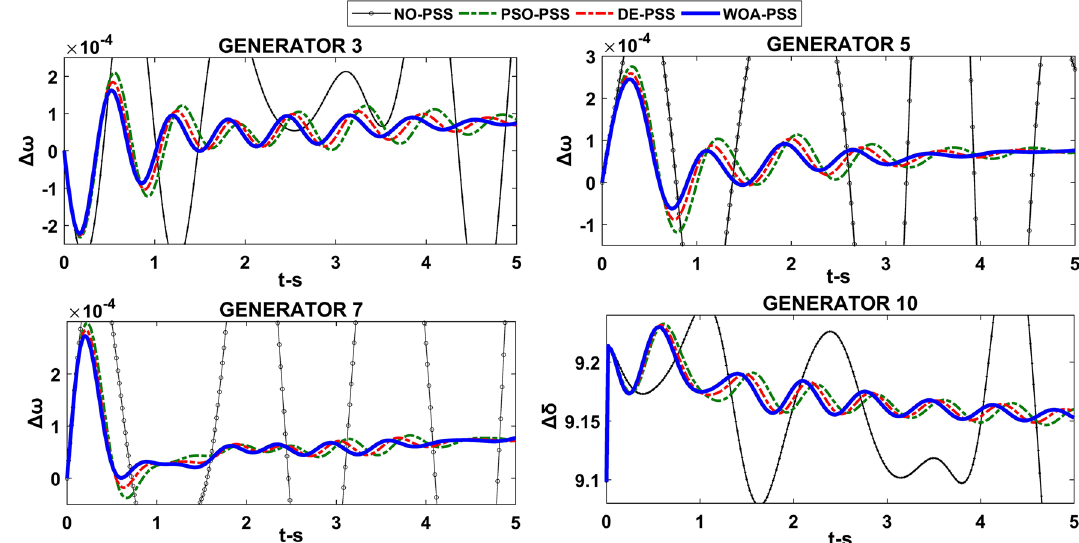
Fig. 11 Speed deviation plots under the disturbance of line outage between 21 and